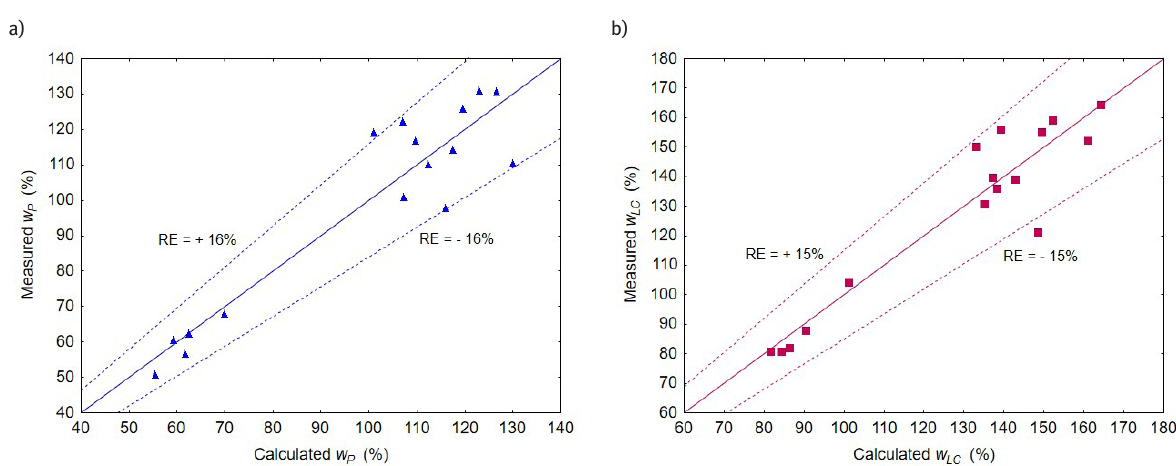
and w from Equation (30) in Table 5, b) w P P